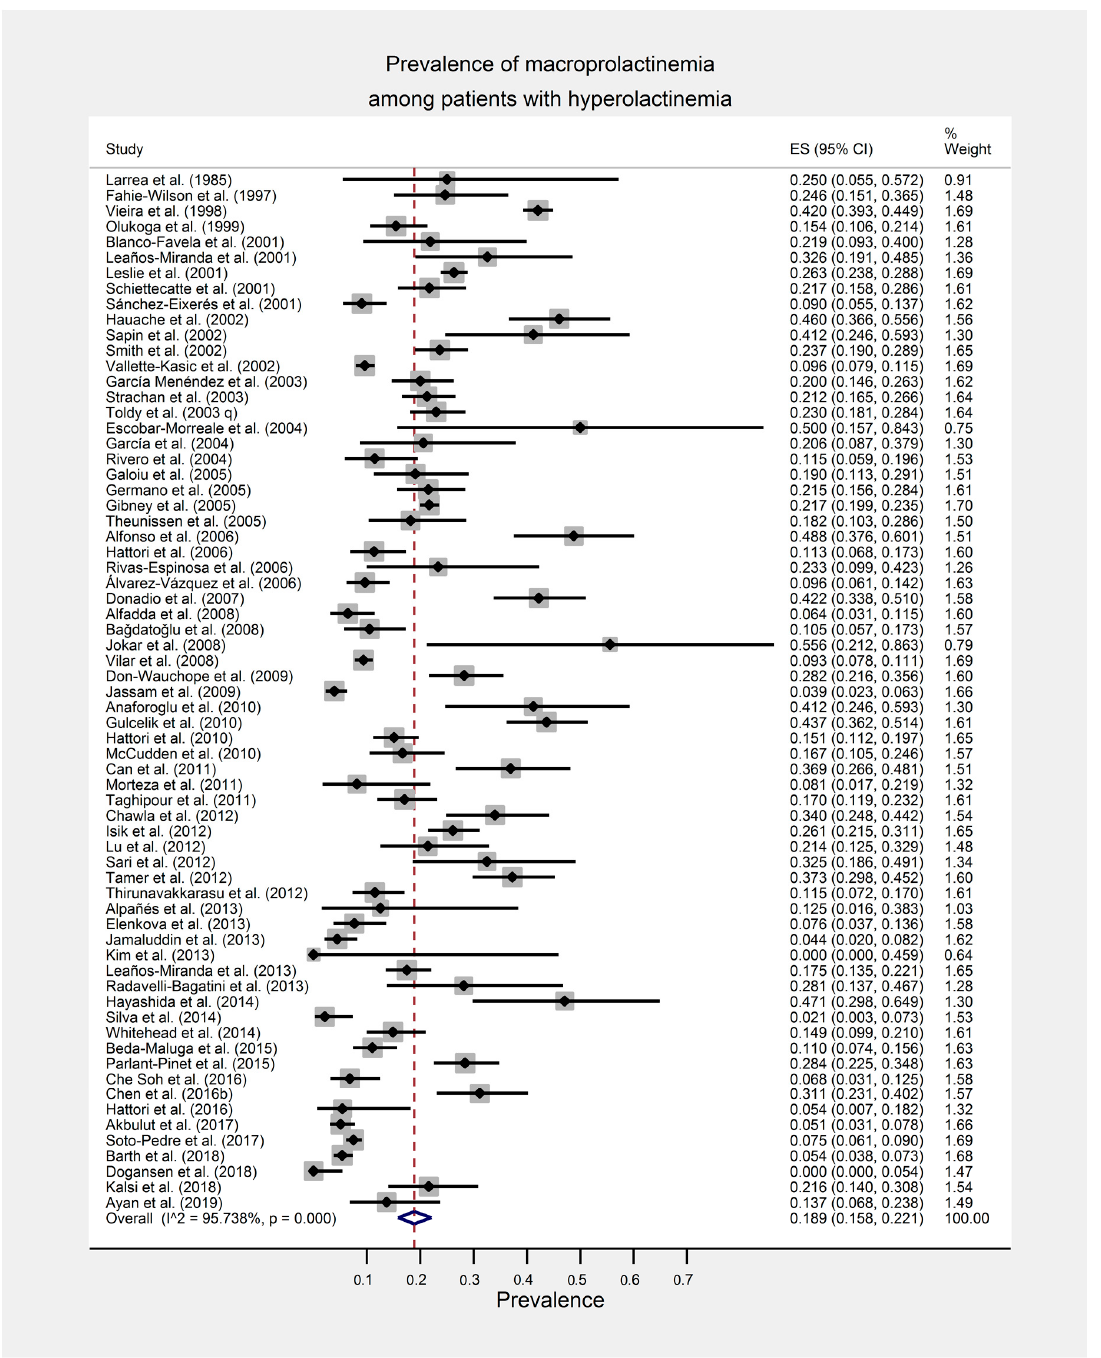
Figure 2. Forest plot of the meta-analysis for the global estimate of the prevalence of macroprolactinemia among patients with hyperprolactinemia.